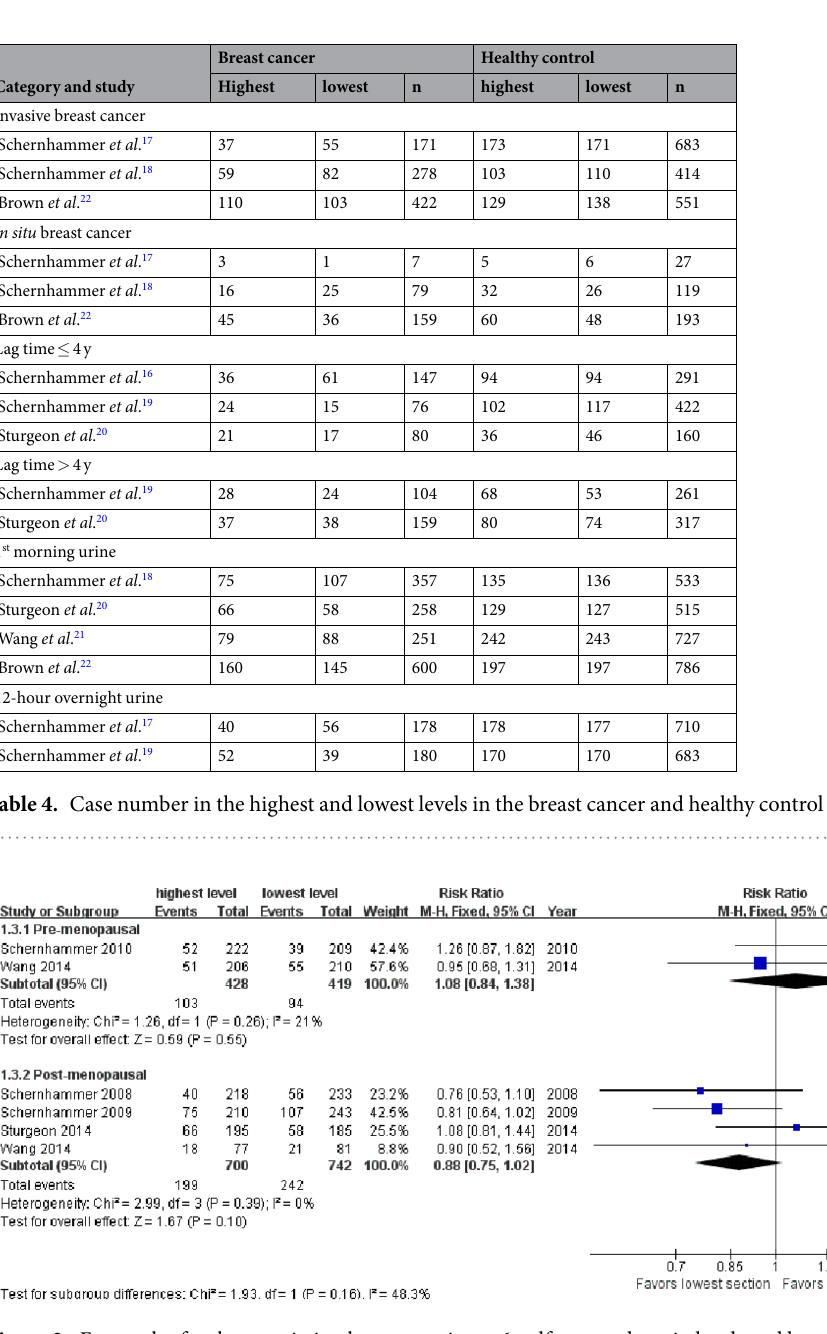
Figure 3. Forest plot for the association between urinary 6-sulfatoxymelatonin levels and breast cancer risk in pre- (upper sub-figure) and post-menopausal (lower sub-figure) women. 6-sulfatoxymelatonin levels are not significantly associated with breast cancer risk among premenopausal participants; while in postmenopausal women, there is an inverse association between 6-sulfatoxymelatonin level and tumor risk with a